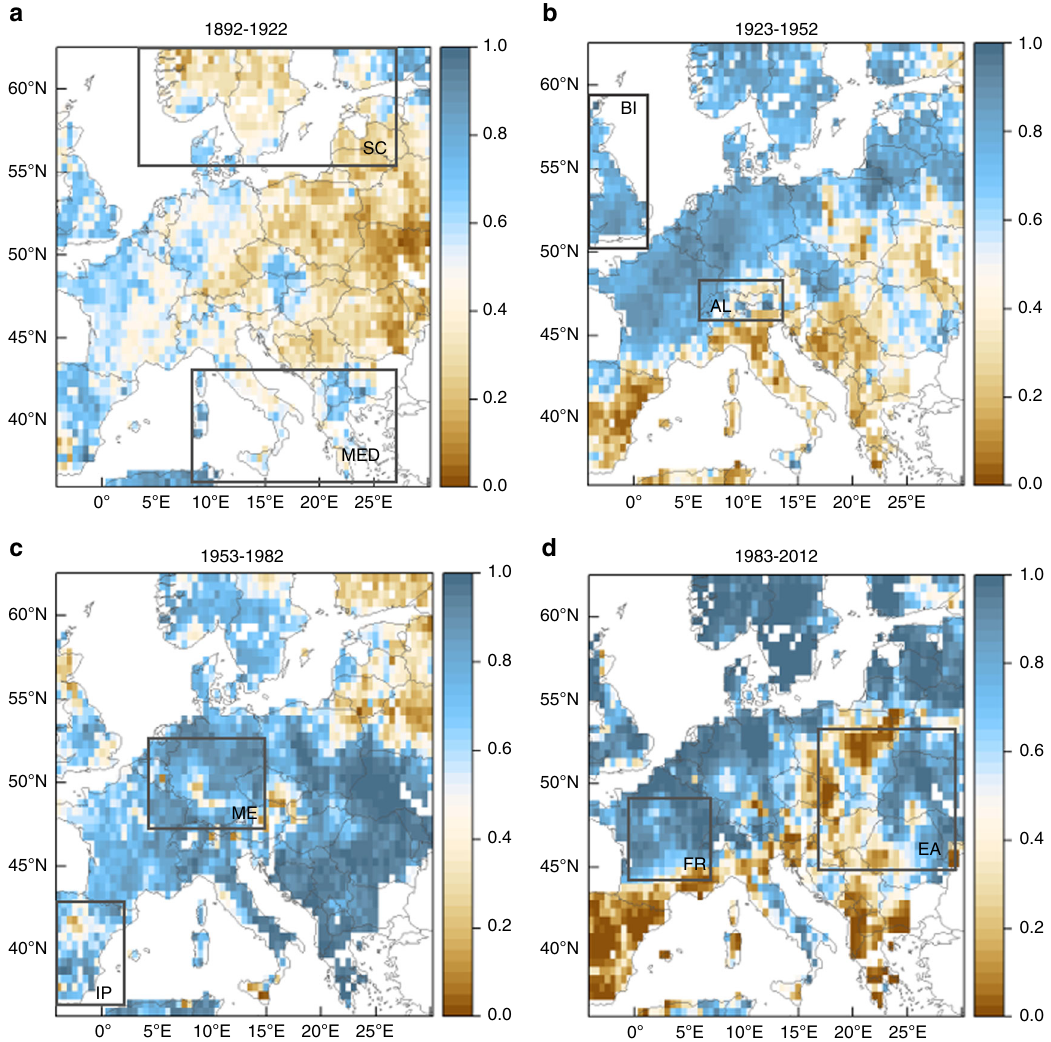
Fig. 3 Spatial evolution of hydroclimatic conditions over 1892 – 2012. Empirical quantiles of 30-year scPDSI ( a 1893-1922, b 1923-1952, c 1953-1982, d 1983- 2012); values close to zero (close to one) represent extremely dry (extremely wet) conditions (AL Alps, BI British Isles, EA Eastern Europe, FR France, IP Iberian Peninsula, ME Mid Europe, MED Mediterranean, SC Scandinavia). The corresponding empirical distributions can be found in Supplementary Fig. 1a